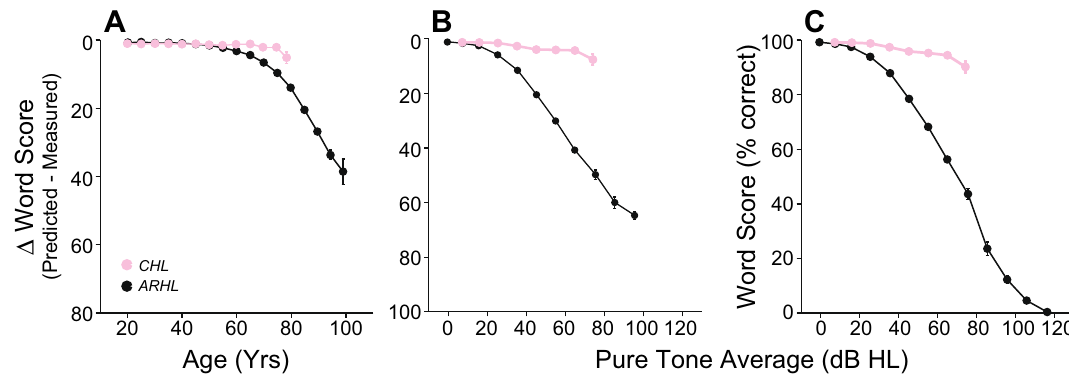
Figure 8. Intelligibility deficits are minimal in patients with conductive hearing loss. ( A ) Intelligibility deficits assessed as differences between measured and predicted words scores as a function of age in patients presenting either a sensorineural hearing loss (SNHL) or a conductive hearing loss (CHL). Legend in ( A ) applies de ( B ) and ( C ). ( B , C ) Decline in word recognition score performance as a function of audiometric loss in patients with SNHL (see Fig. 4) are compared to patients presenting with a CHL. Intelligibility deficits were assessed either by calculating the difference between measured word score and score predicted by the speech intelligibility curve ( B ) or by measuring word recognition scores at PB max ( C ). Error bars are standard error of mean.